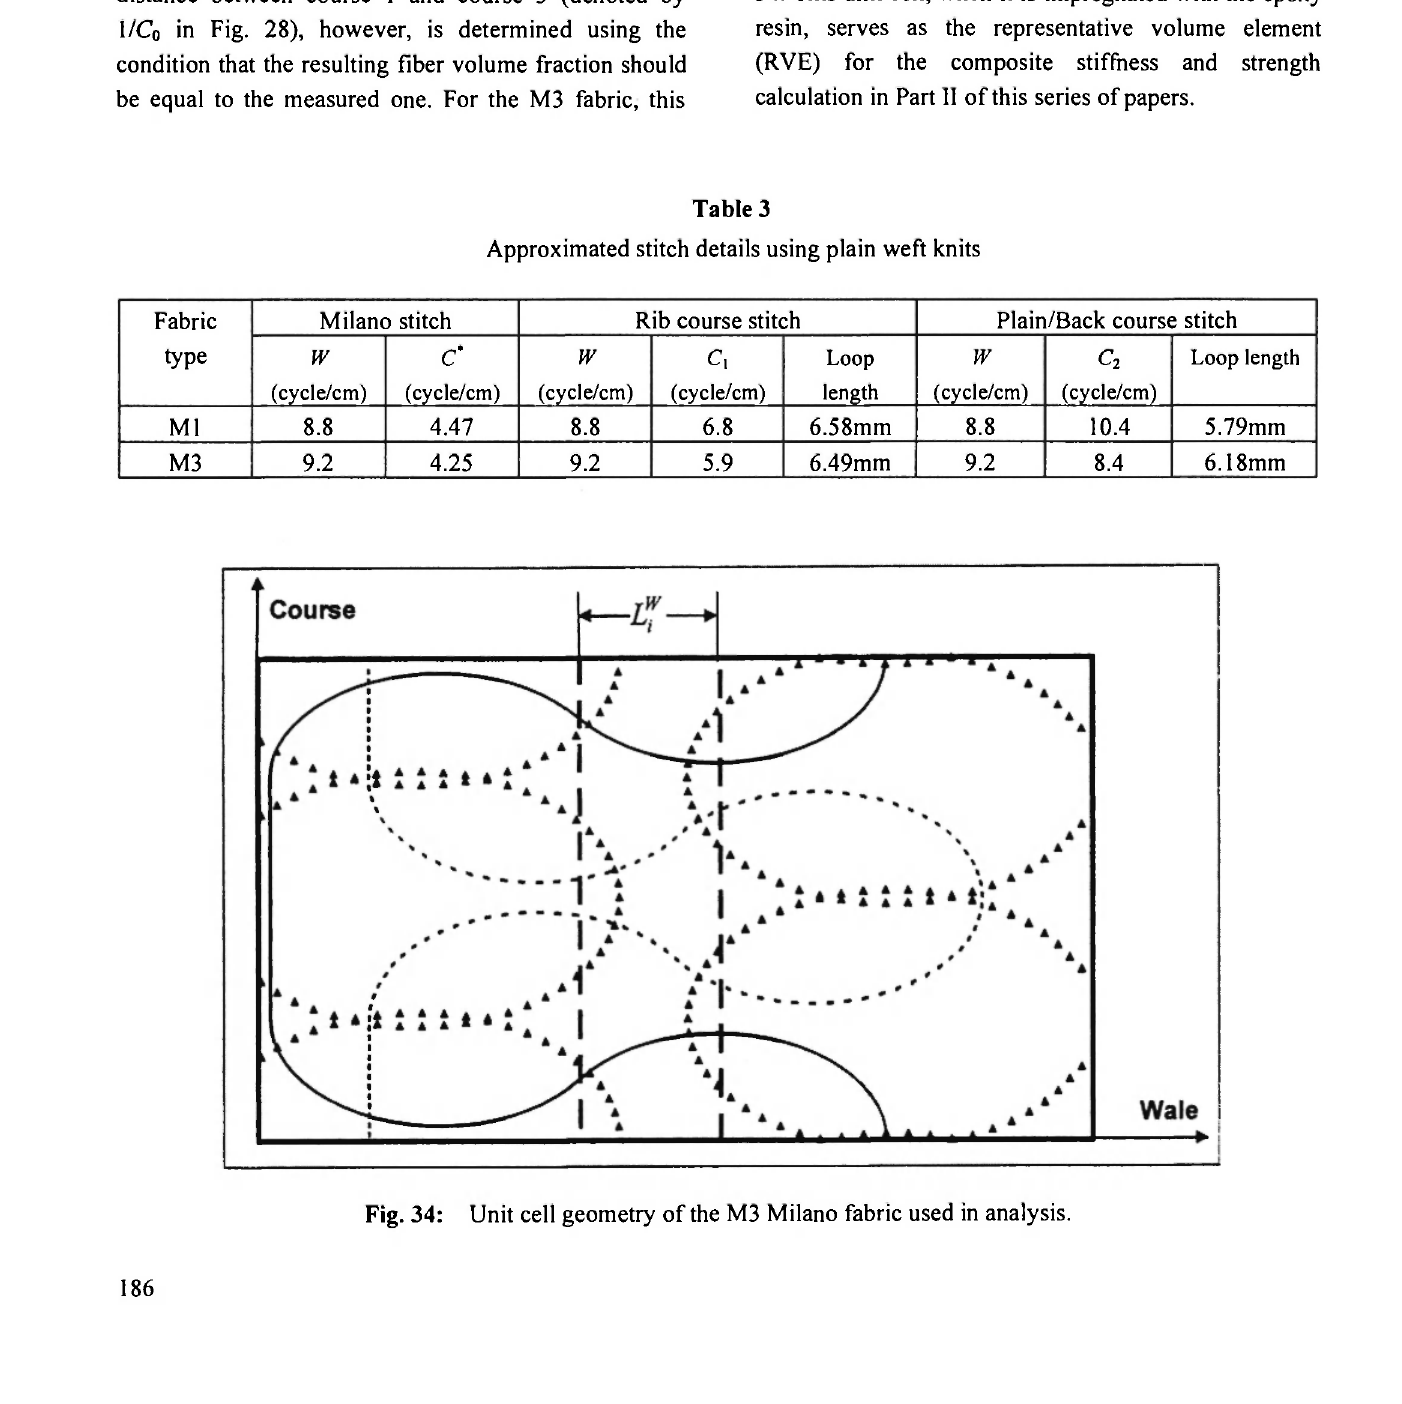
Unit cell geometry of the M3 Milano fabric used in